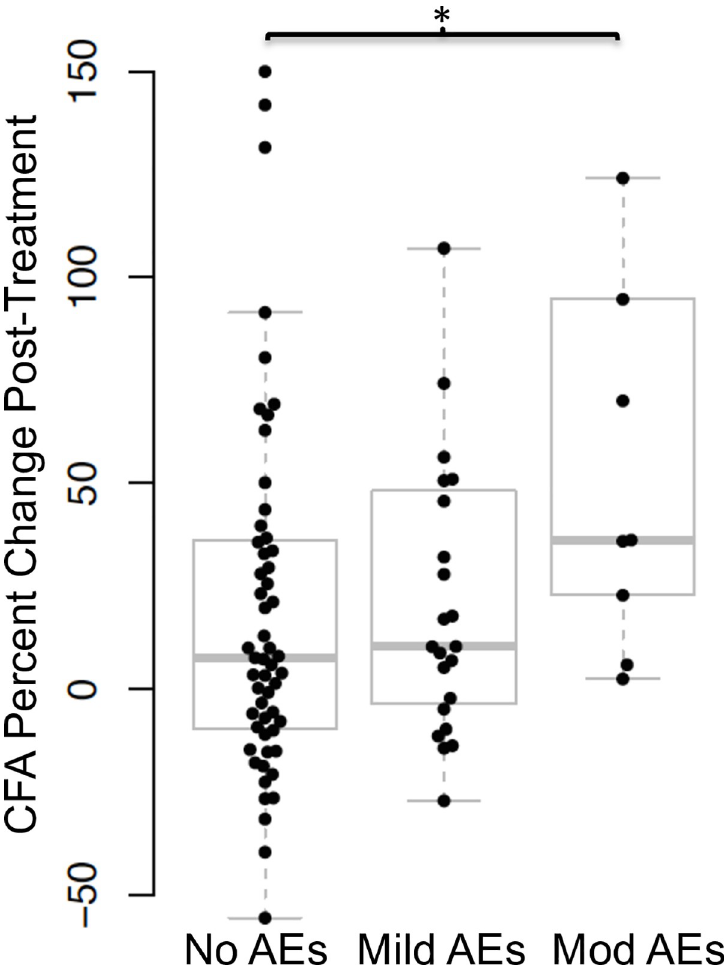
Fig 1. Filarial antigens increase post-treatment in individuals with moderate adverse events (AEs). Circulating filarial antigen (CFA) levels increased significantly more post-treatment in individuals who experienced moderate adverse events (mod AEs) compared to individuals with no AEs ( P < 0.05 by Kruskal-Wallis) (n = 62 with no AEs, n = 24 with mild AEs, n = 9 with moderate AEs). Boxes indicate the interquartile range (25 th and 75 th percentile of data distribution), and horizontal lines within the boxes are median values. The whiskers show 95% confidence intervals around the median